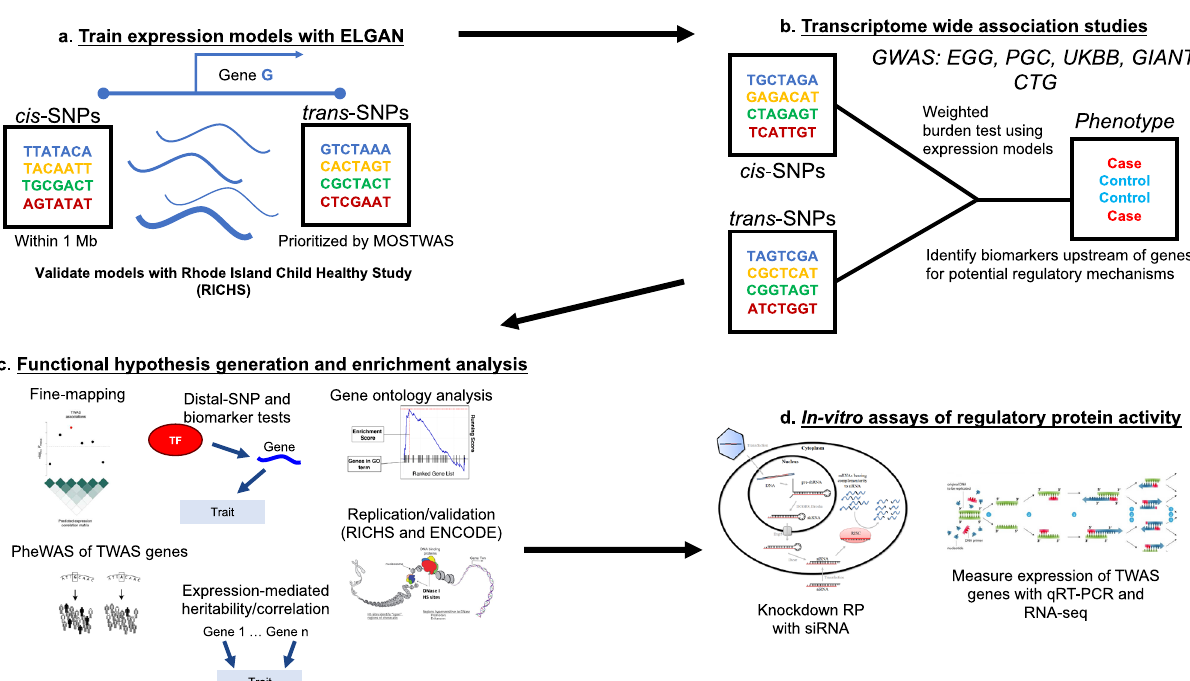
Fig. 2 Overview of analytic pipeline. a Predictive models of placental expression are trained from germline genetics, enriched for mediating biomarkers using MOSTWAS 22 and externally validated in RICHS 36 eQTL data. b Predictive models are integrated with GWAS for 40 traits to detect placental gene- trait associations (GTAs). c GTAs are followed up with gene ontology analyses, probabilistic fi ne-mapping, and phenome-wide scans of genes with multiple GTAs. Relationships between identi fi ed distal mediators and TWAS genes are investigated further in RICHS and ENCODE 10 . Expression-mediated genetic heritability of and correlations between traits are estimated. d In vitro validation of prioritized regulatory protein-TWAS gene pairs are conducted using placenta-derived choriocarcinoma cells by gene silencing, qRT-PCR, and RNA-seq to measure transcriptomic impacts of the regulatory